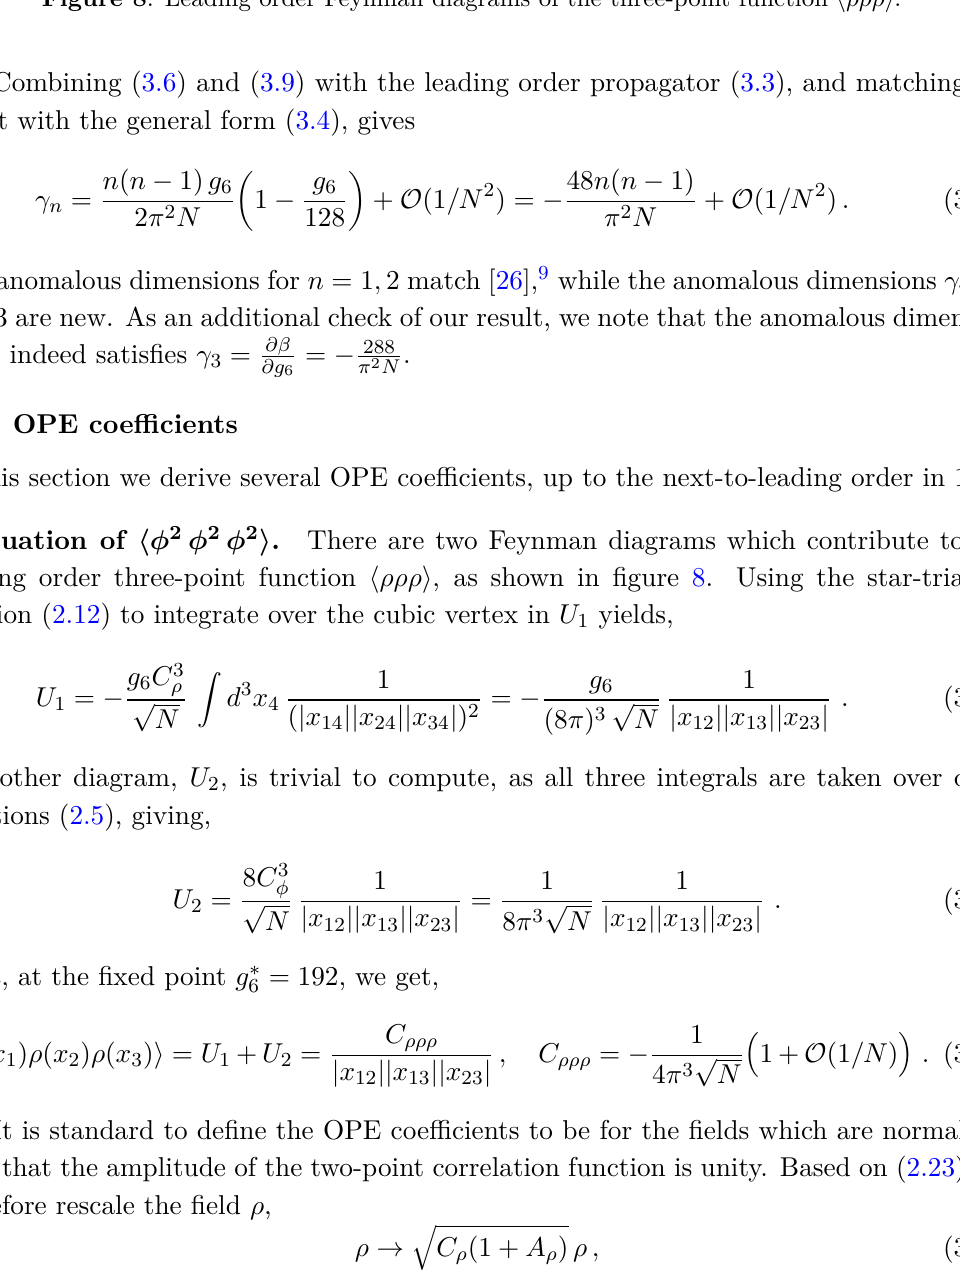
Figure 8 . Leading order Feynman diagrams of the three-point function